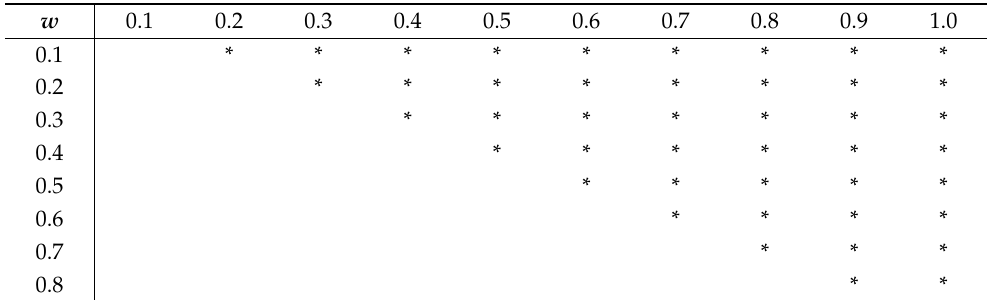
Table 5. Statistical significance in roughness perception for p -constant samples with various w values. * Significance level < 0.05. N.S. means not